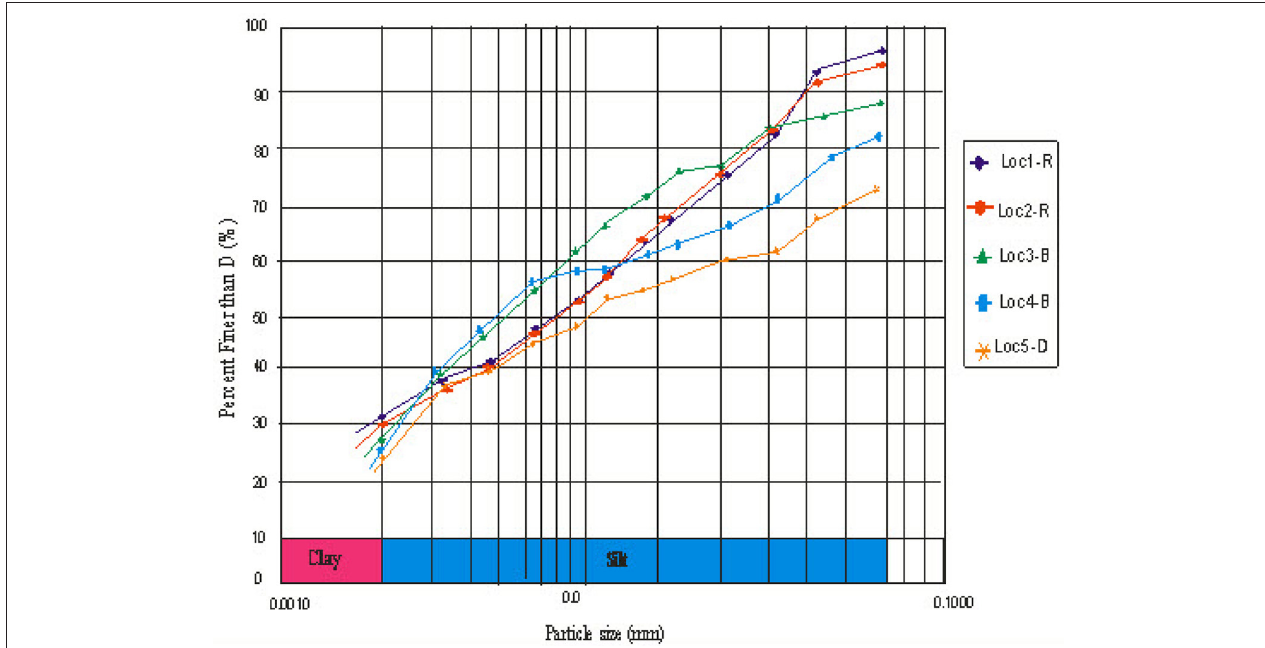
FIGURE 2 | Grain size distribution of samples (Source: analysis of results).